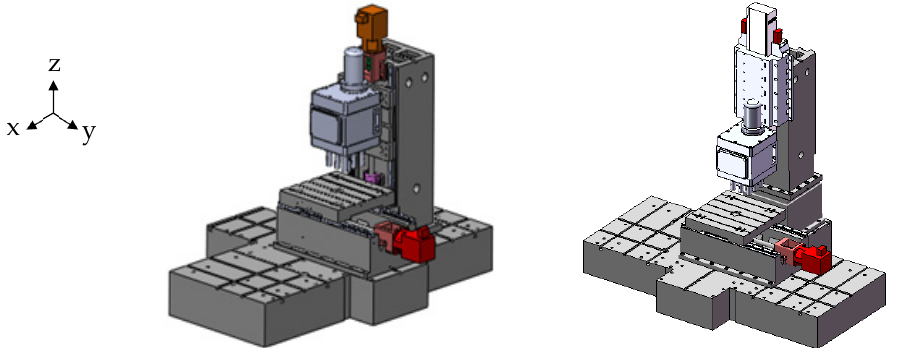
Figure 16. Two generated RMTs corresponding to the machining operations of the 2nd processing segment of the processing plan of part 1.